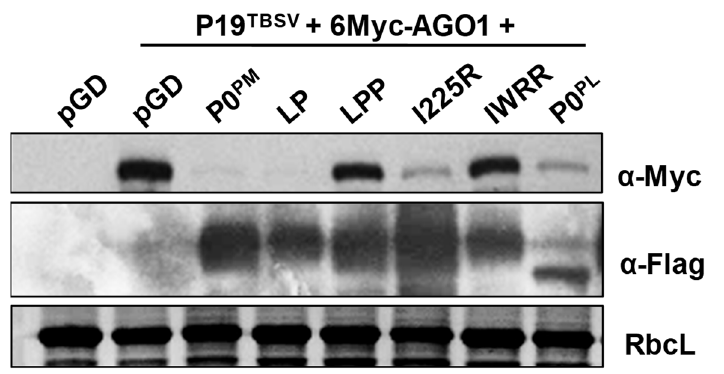
Figure 5. Effect of P0 PM and its mutants on the accumulation of AGO1 protein. The 6Myc-tagged AtAGO1 was transiently co-expressed with 3Flag-tagged P0 PM and its mutants in N. benthamiana leaves through agroinfiltration in the presence of P19 TBSV . Protein samples were prepared from plant leaves at 5 dpi. The accumulation of AtAGO1 and P0 PM and its mutants was detected by Western blotting. AtAGO1 was detected with c-Myc monoclonal antibody; P0 PM and its mutants were detected with Flag monoclonal antibody. RbcL is the Rubisco large subunit.